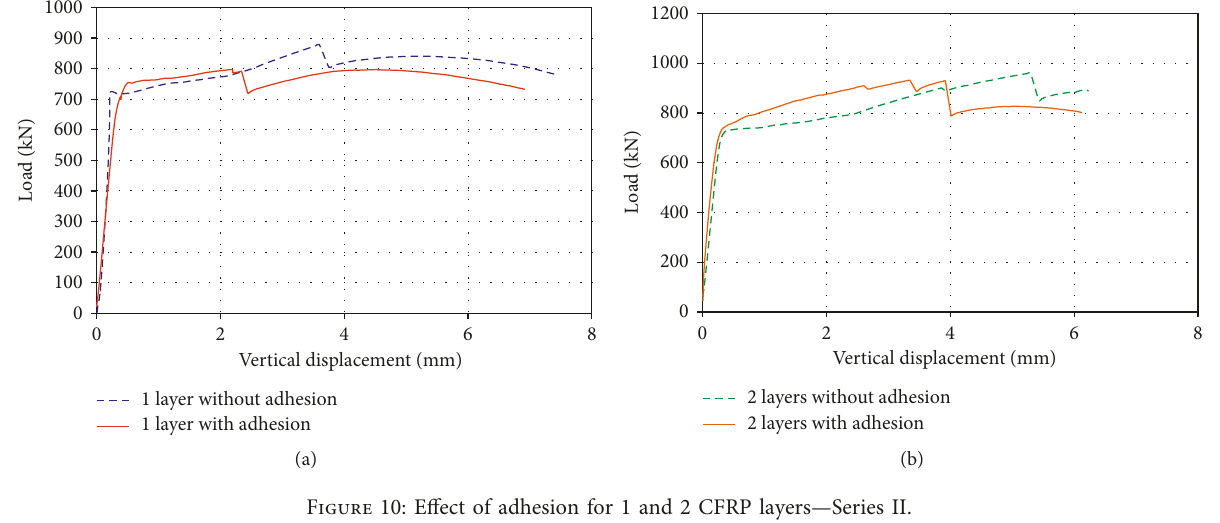
Figure 10: Effect of adhesion for 1 and 2 CFRP layers—Series II.